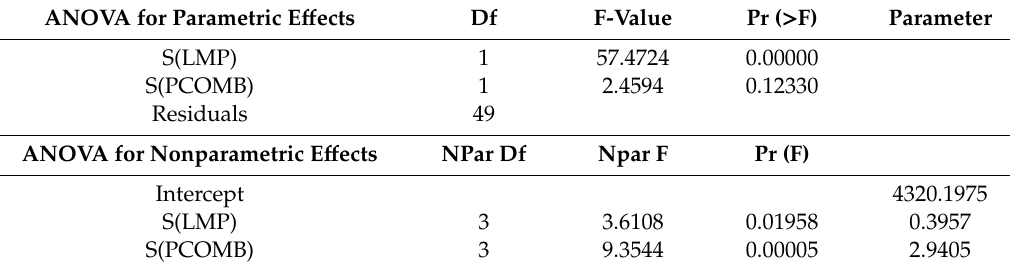
Table 2. Generalized additive model (GAM) parameter estimations.